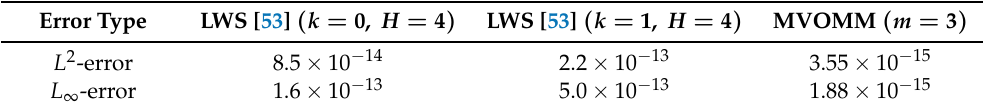
Table 6. Comparison between the LWS introduced in [53] and the current study for Example 4 with various